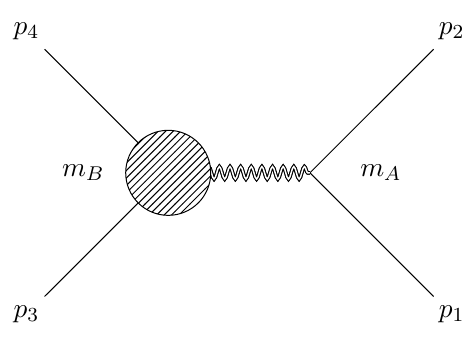
Figure 1 . Gravitational probe of charged, spinning